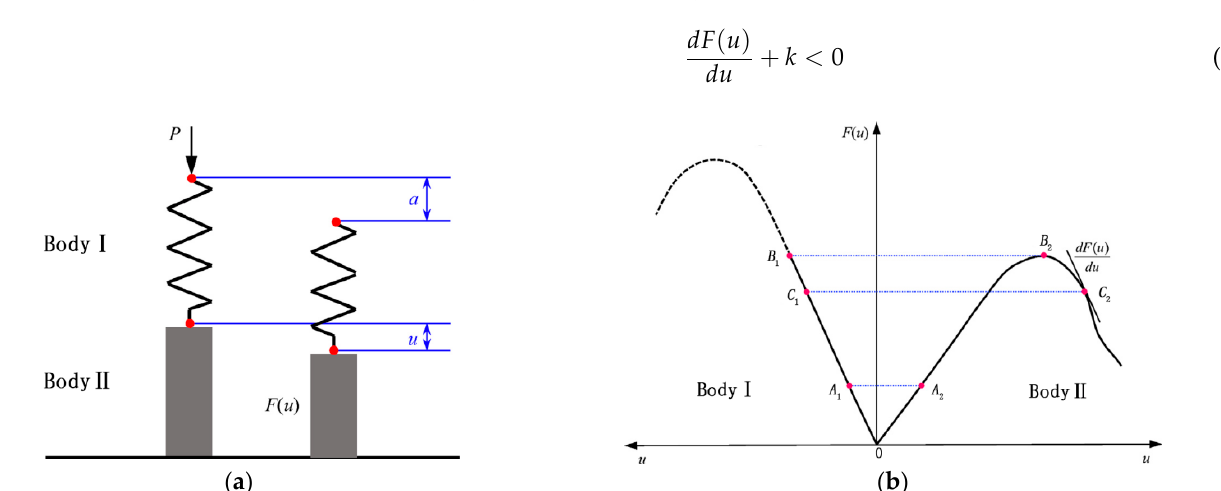
Figure 6. Two-body interaction model ( a ) and constitutive curve ( b ).